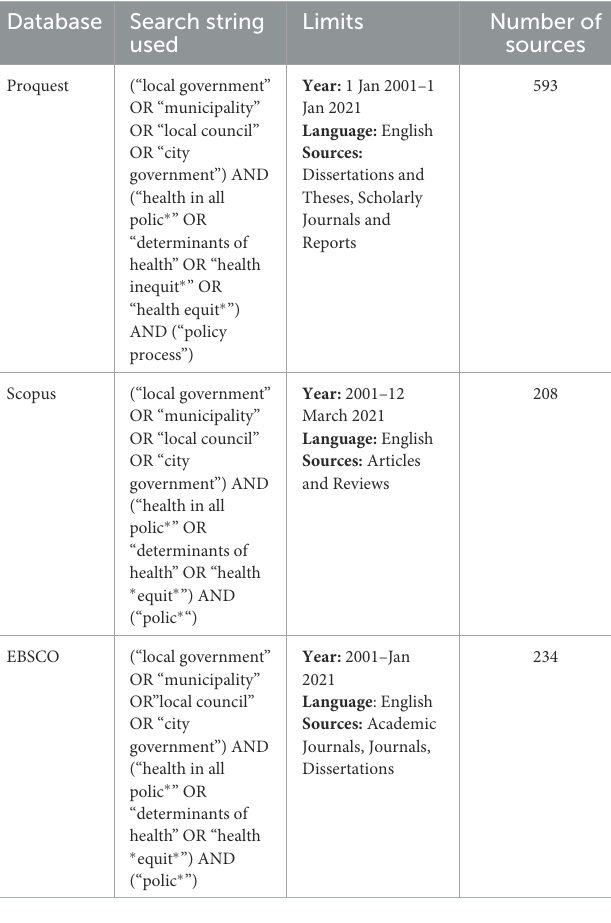
TABLE 1 Database search, including search strings, limits and number of sources (after removing duplicates within databases).